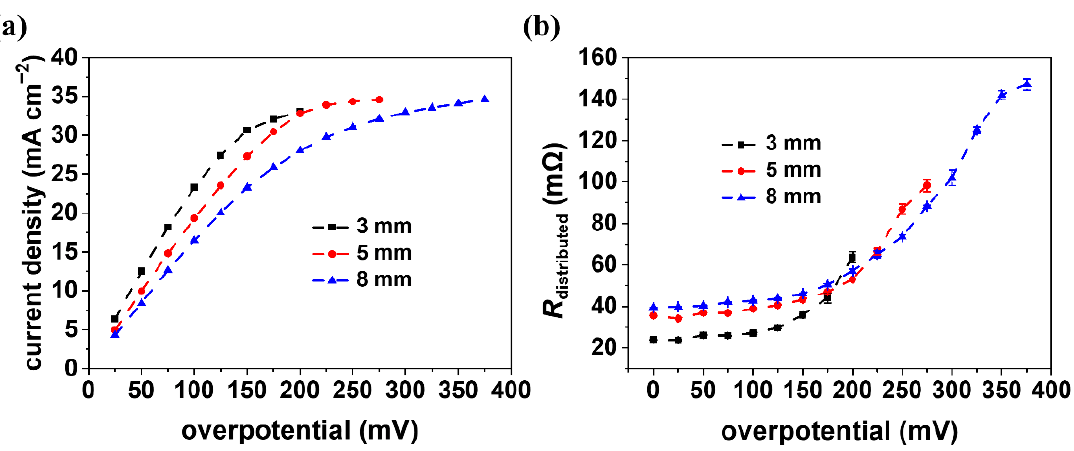
Figure 6. Effect of electrode thickness on the current density and the distributed resistance. ( a ) Polarization curves; ( b ) Distributed resistance derived from the data fitting. The electrolyte concentra ‐ tion was 0.050 M K 3 [Fe(CN) 6 ] at 50% SOC. All measurements were performed at a flow rate of 20 mL min ‐ 1 at corresponding anodic polarization.